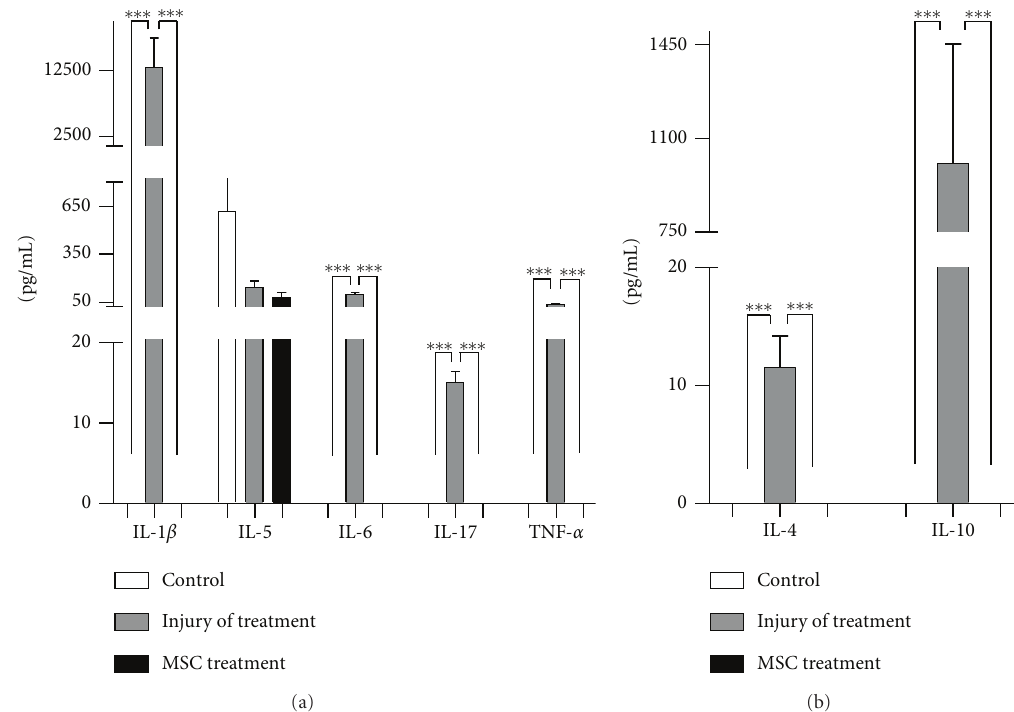
Figure 2: Cytokine profile in serum in TBI acute phase. Serum from mice submitted to the TBI protocol was used to investigate for cytokines content. Mice were transplanted (MSC treated) or not (injury not treated) with MSC immediately after the injury and blood was collected after 24 hours. (a) Pro-inflammatory cytokines and (b) anti-inflammatory cytokines (control n = 3, injury no treatment n = 6, MSC treated n = 4). ∗∗∗ P < . 001, ∗∗ P < .